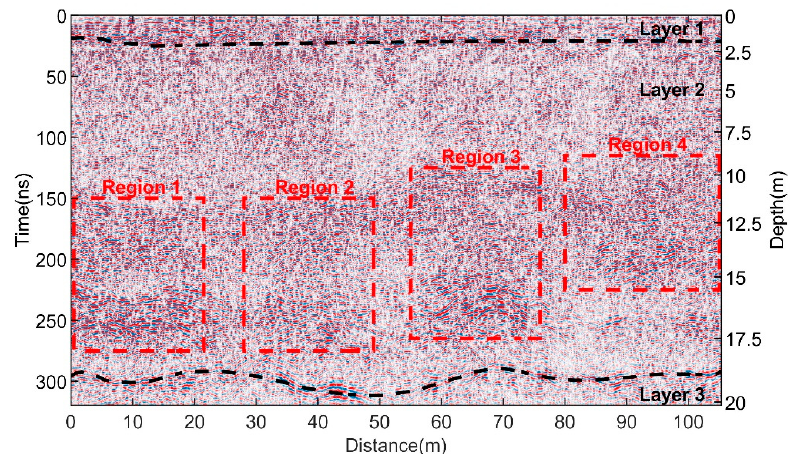
Figure 9. Analysis of radargram.